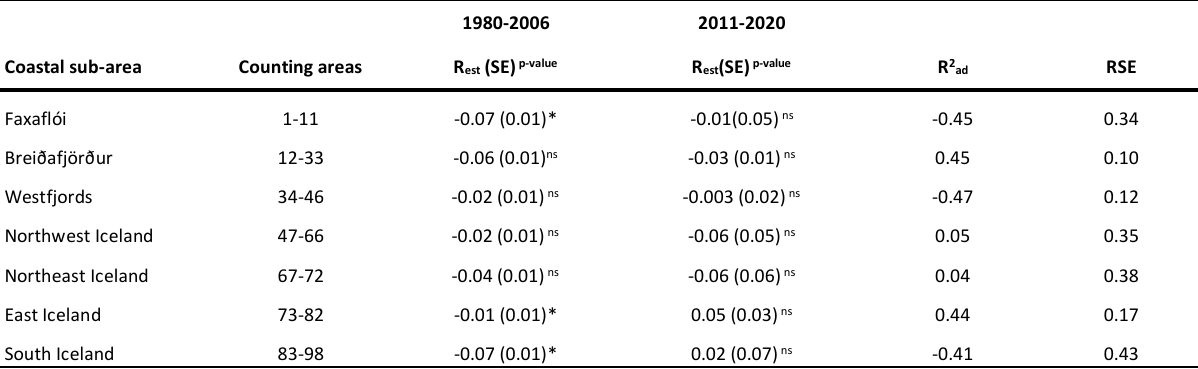
Table 2: Coastal sub-areas and the corresponding counting areas (see Figure1), trends in harbour seal abundance in each coastal sub-area for the periods 1980–2006 (published in Hauksson, 2010) and 2011–2020: exponential growth rate (R est ), standard error (SE) and p-value (Significance levels: ns = not significant, * significant at the 5%, ** 1 % and *** 0.1%). Adjusted coefficient of determination (R 2ad ) and residual standard error (RSE) are shown for the latter